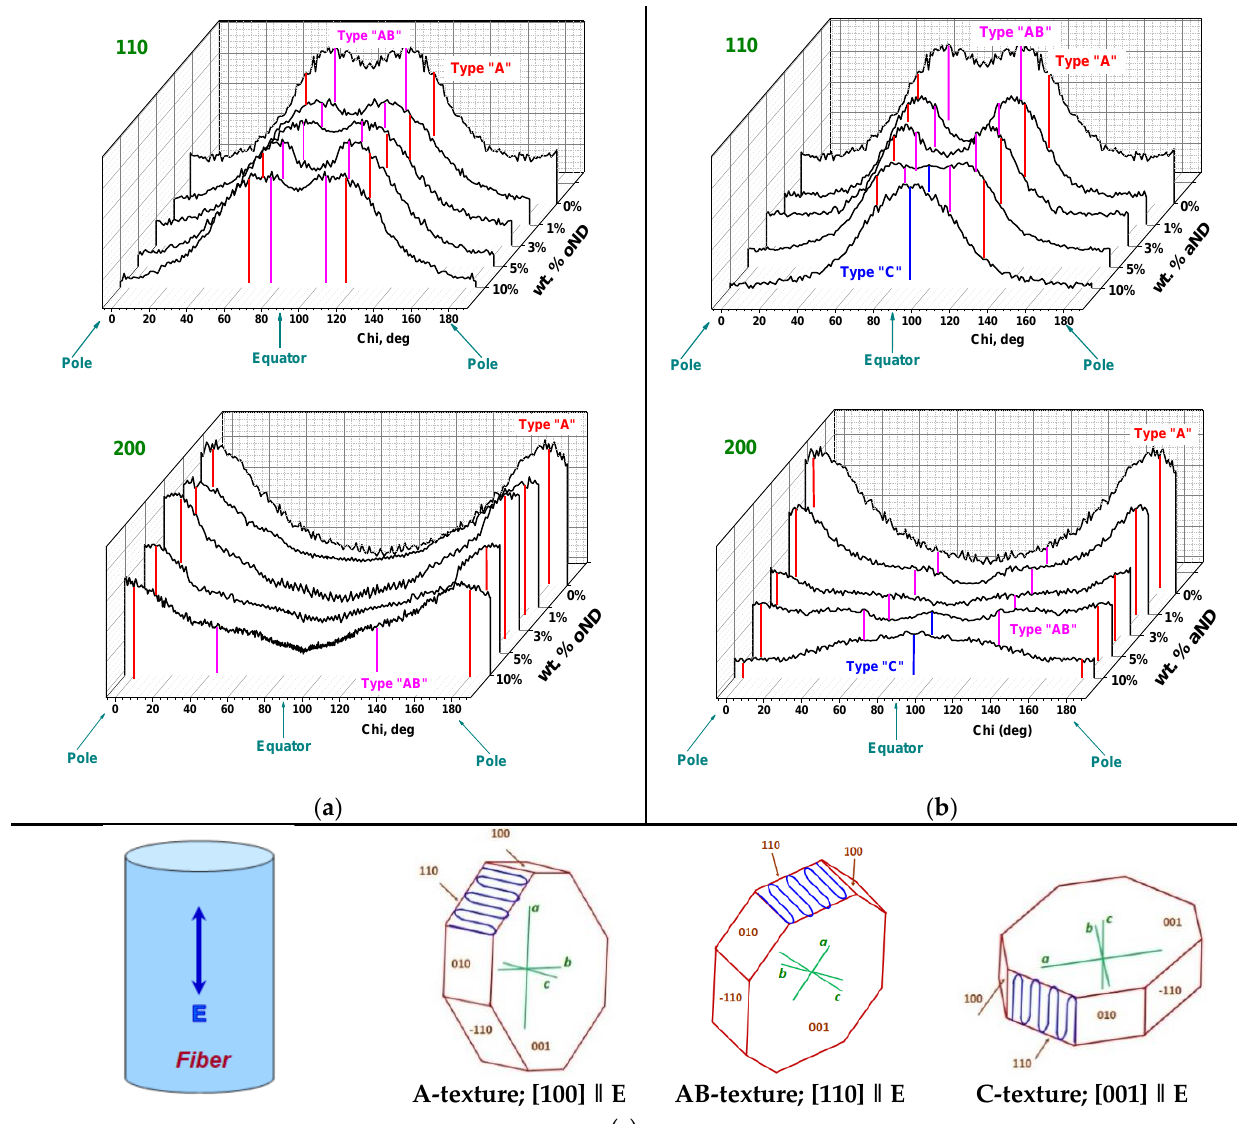
Figure 10. Azimuthal X-ray intensity distributions of the main reflexes, 110 and 200, recorded for the HDPE-based fibers: ( a ) HDPE + 5 wt. % oND; ( b ) HDPE + 5 wt. % aND; ( c ) schematic interpretation of the HDPE crystalline texture and macromolecular folding (blue line). E is the fiber extrusion direction.